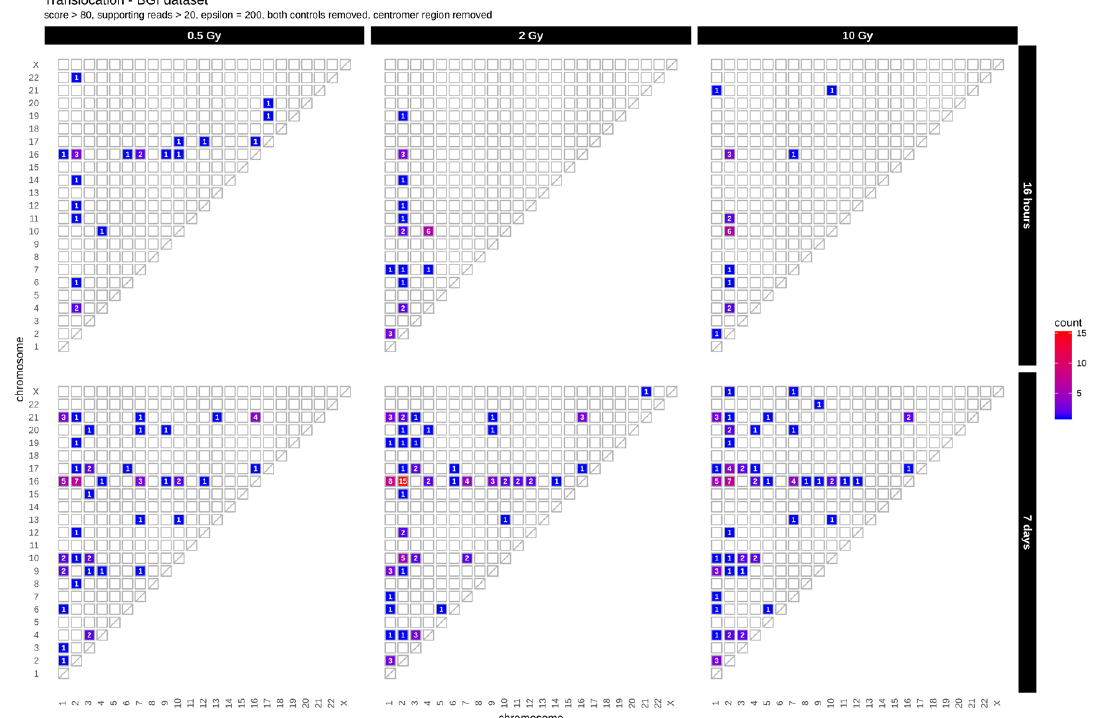
Figure 1. Translocation counts between chromosomes (irrespective of the direction) in genome dataset 1 (generated with BreakDancer).